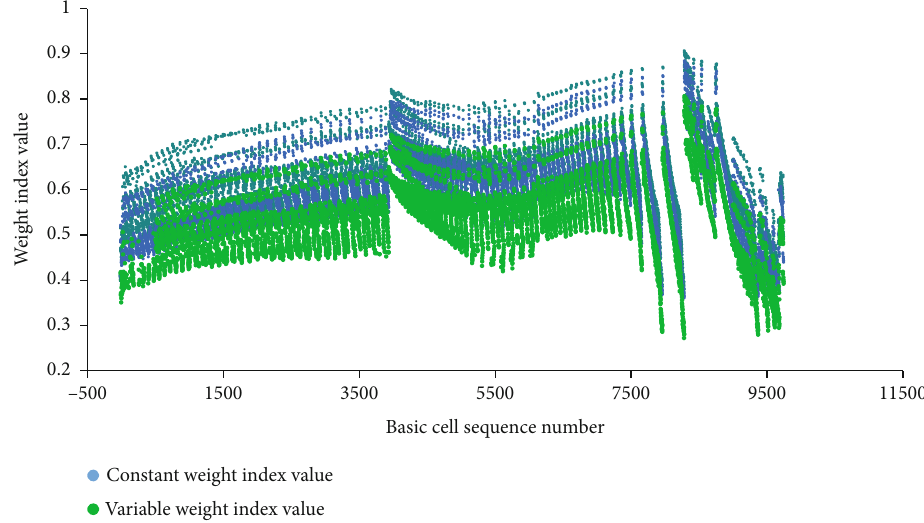
Figure 8: Comparison of the range of comprehensive evaluation